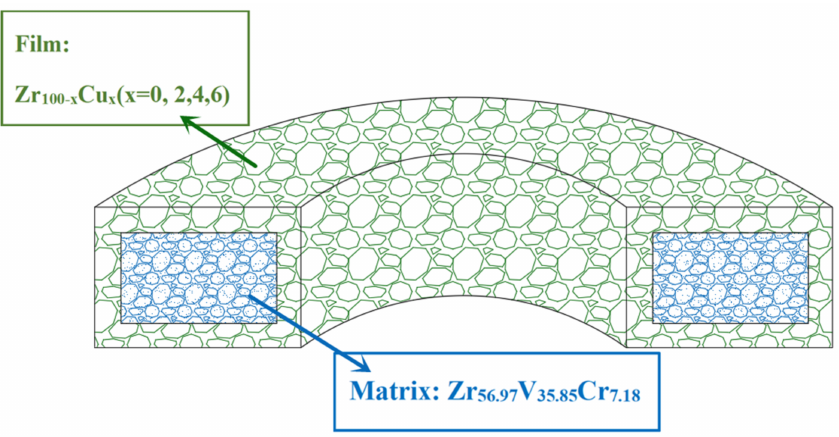
Figure 1. Design principal diagram of gradient structure Zr-V-Cr